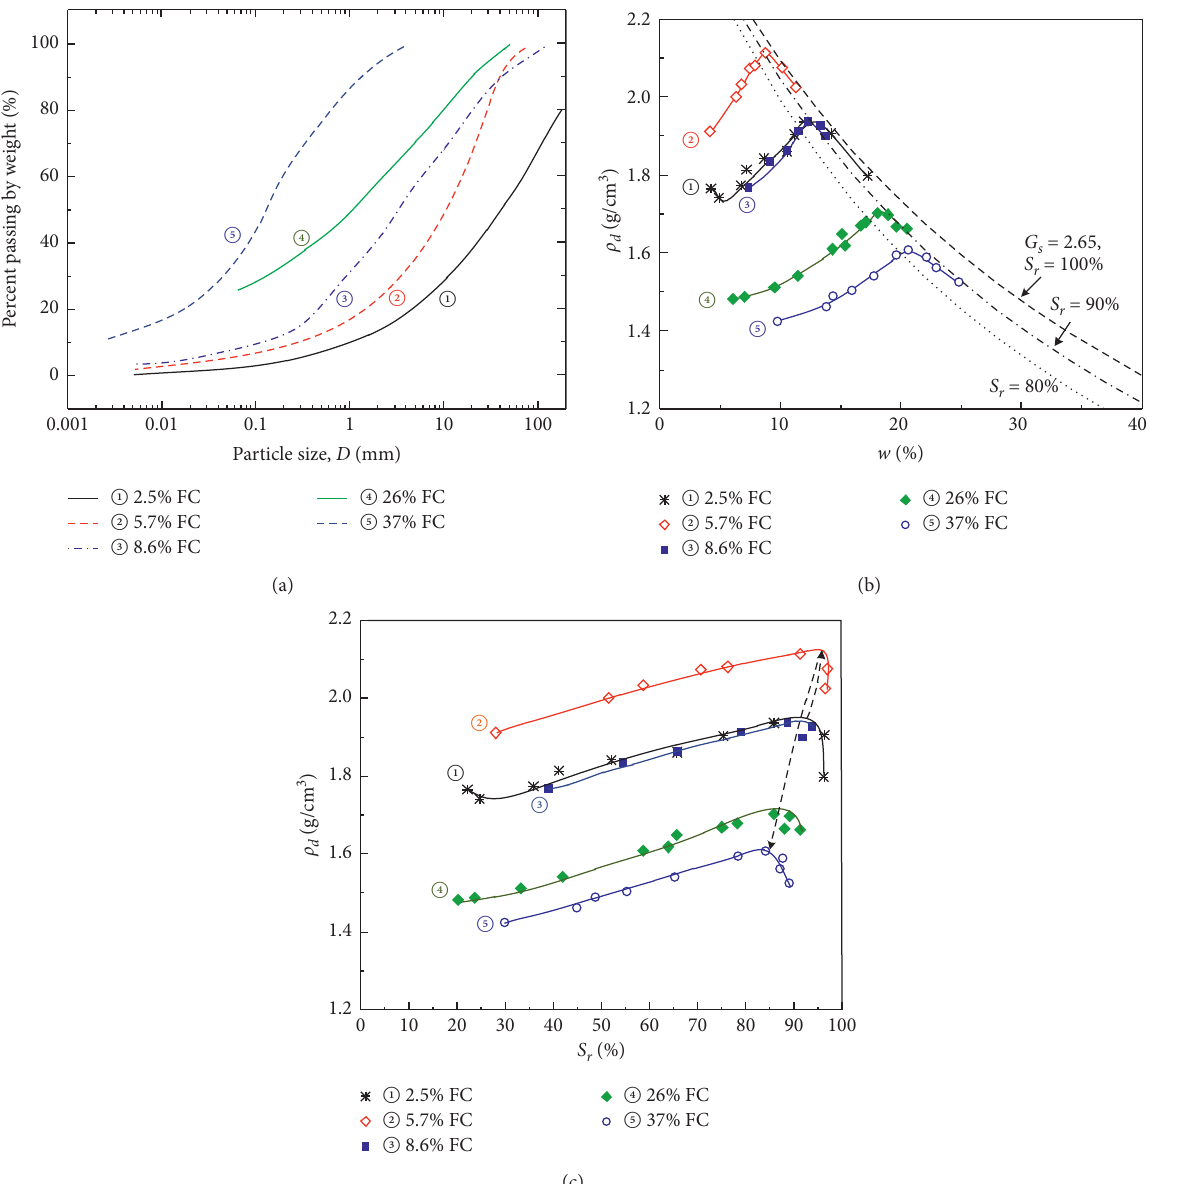
Figure 10: Five soil types sampled around Miboro Dam site [33]: (a) grading curves; (b) compaction curves; (c) dry density ρ against saturation degree S r